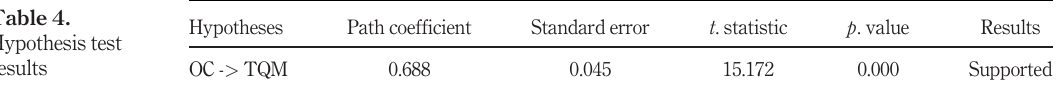
Table 3. Predictive relevance of the model